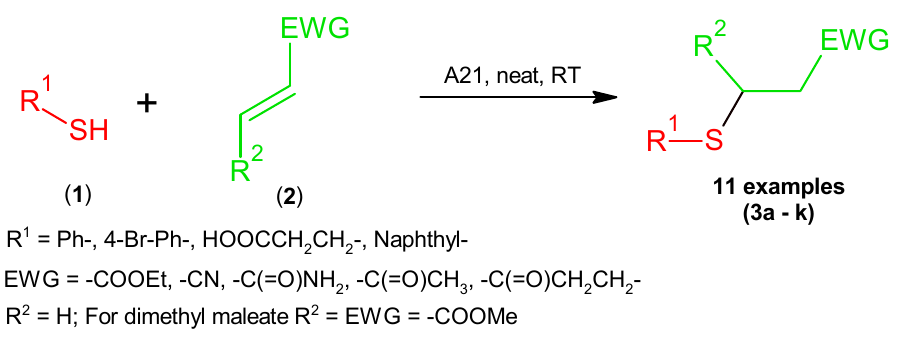
Scheme 1. General reaction scheme for thia-Michael addition catalyzed by Amberlyst ®